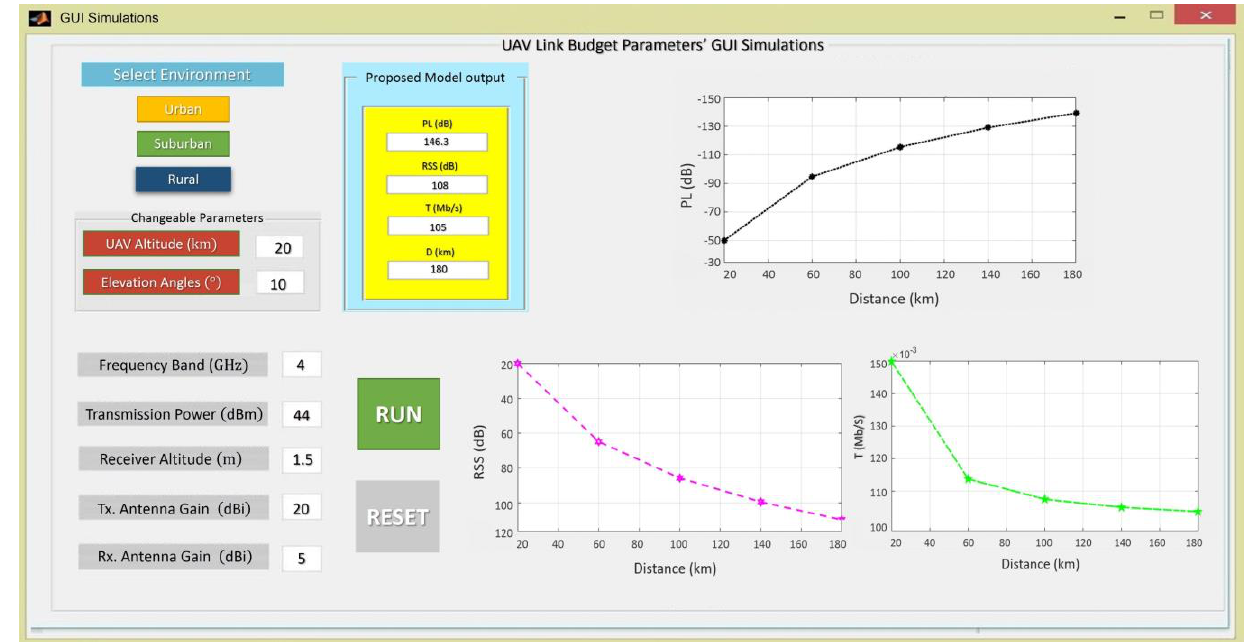
Figure 8. UAV link budget parameters using the GUI toolbox in MATLAB.